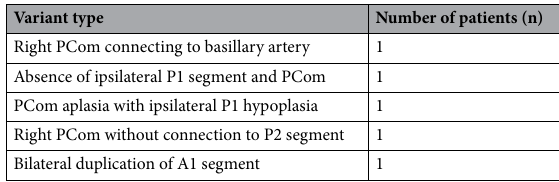
Table 3. Other variants of the COW * . *Circle of Willis.